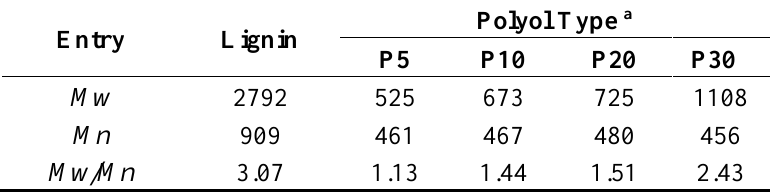
Table 2. Weight-average ( Mw ) and number-average ( Mn ) molecular weights and polydispersity ( Mw / Mn ) of the four